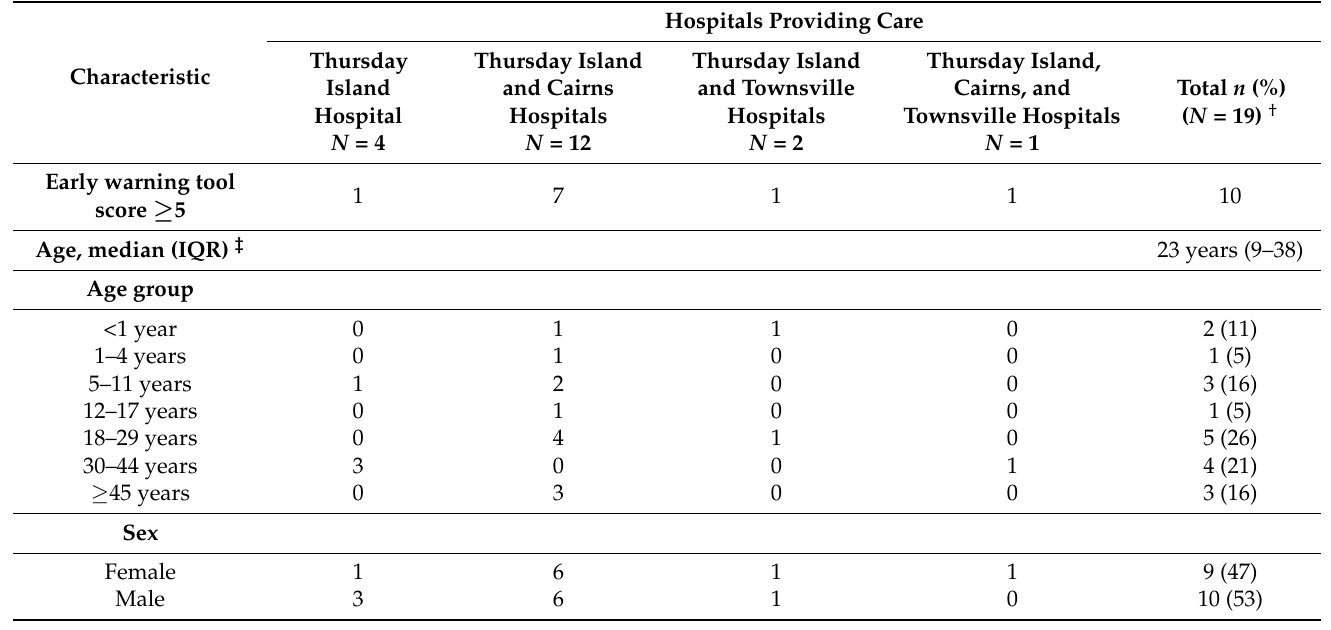
Figure 1. Outcomes of PNG nationals who presented with presumptive TB to primary health centres in the Torres Strait, Australia, between 2016 and 2019 according to their early warning score (Note. Initial score—this score is determined upon arrival to the health centre; † Includes four patients that did not have repeat vitals at time of discharge; ‡ Includes one patient that remained on oxygen at the time vital signs, including oxygen saturation levels, were being recorded prior to discharge; § It is unknown whether patients died due to tuberculosis or other causes). Table 1. Characteristics of Papua New Guinea nationals diagnosed with tuberculosis requiring aeromedical evacuation from the Torres Strait, Australia from 2016–2019 ( N =